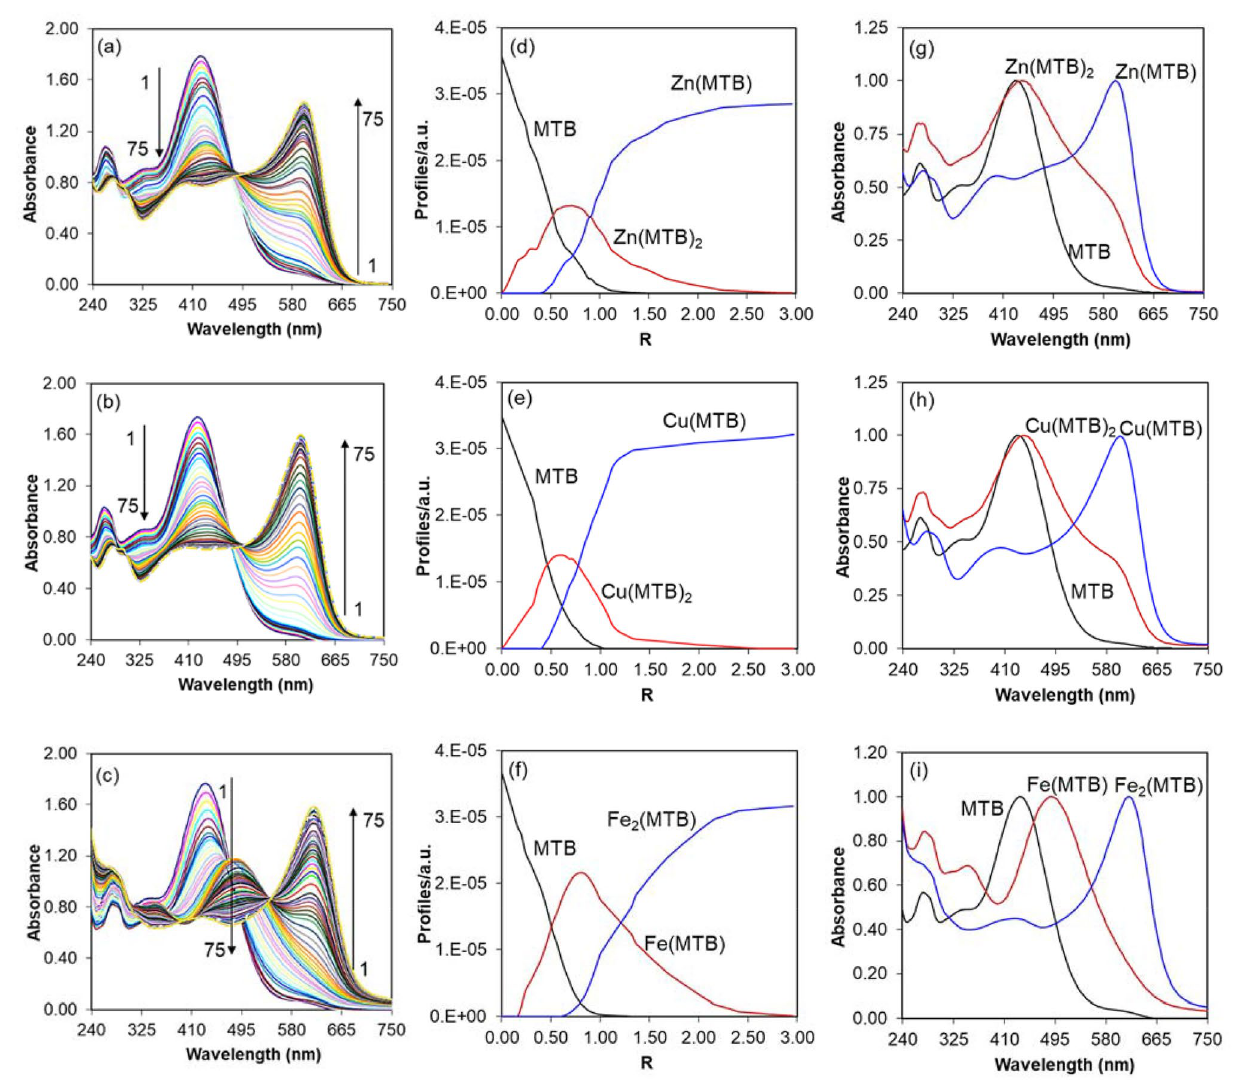
Figure 4. UV–Visible spectra of the complexation systems of MTB with ( a ) Zn II , ( b ) Cu II and ( c ) Fe II , the concentration ( d – f ) and spectral ( g – i ) profiles obtained using MCR-ALS. The numbers 1 and 75 corresponds to 0 and 2.96 R values, respectively. The LOF values were below 1%.